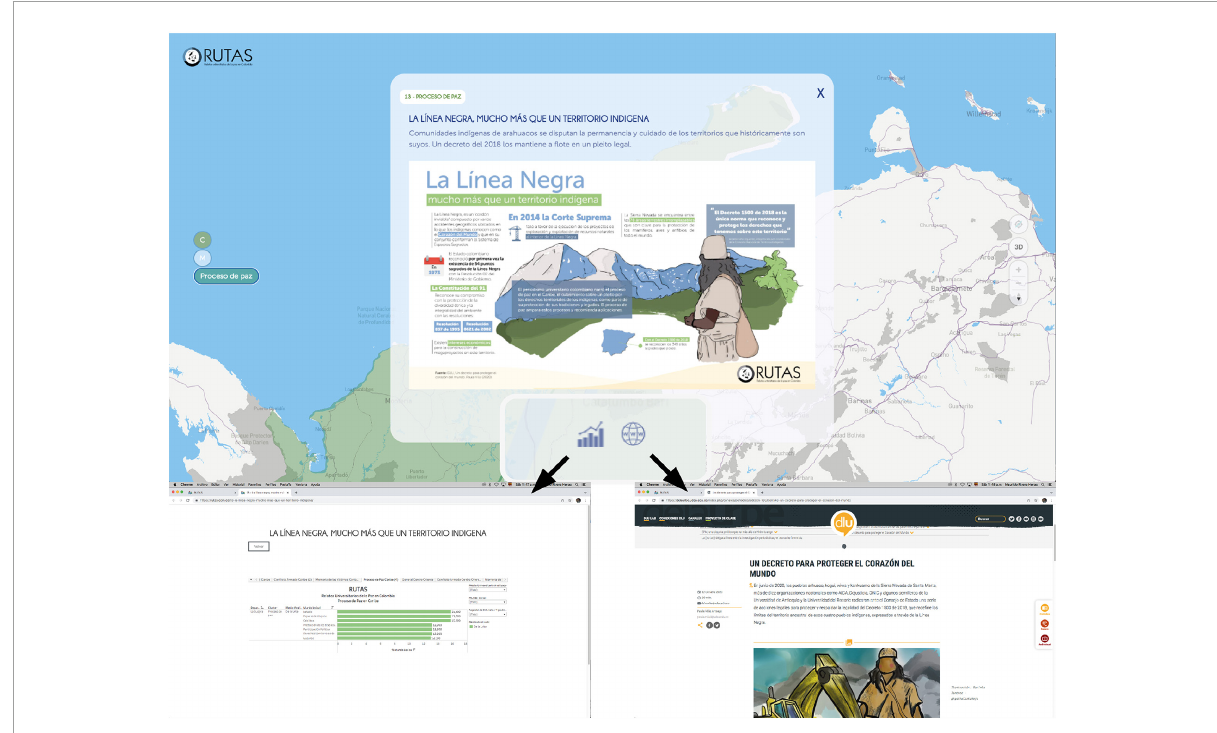
FIGURE5 Cluster navigation views Peace Process, analysis result in tableau, and the student’s news. Source: RUTAS